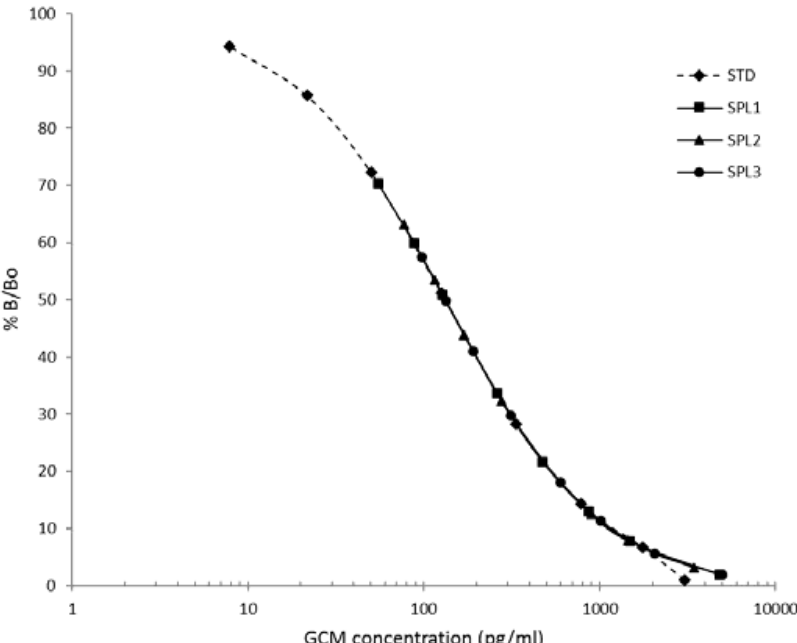
Figure 1. Test for parallelism. The supernatants of three extracts of African Grey Parrots’ droppings (SPL1, SPL2, SPL3) were serially diluted and compared to the standard curve (STD) of the CCC EIA kit. X -axis shows the concentration of GCM obtained from the kit in pg/mL. Y -axis is the percent of binding (B)/total binding (Bo).